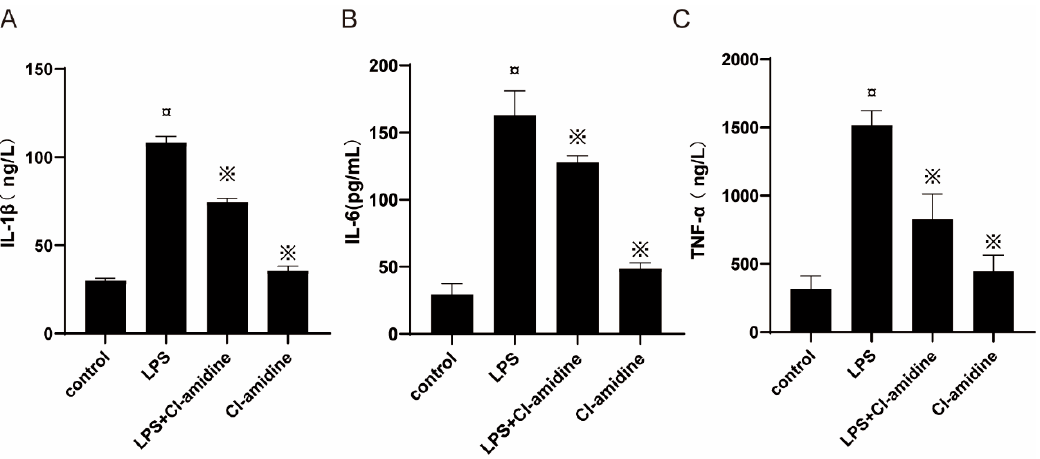
Figure 2. Effects of Cl-amidine on the mRNA levels of pro-inflammatory cytokines in the LPS-induced rat endometritis. Endometritis induced by infusion of LPS (1 mg/kg body weight) into the uterine cavity, later treated with Cl-amidine or vehicle (saline) as required. Samples were collected 24 h after induction of endometritis and Cl-amidine treatment. The mRNA levels of ( A ) IL-1 β , ( B ) IL-6, and ( C ) TNF- α were measured by RT-PCR. Data were represented by mean ± SD ( n = 5 animals per group). ¤ p < 0.05 vs. control rats and ※ p < 0.05 vs. LPS without Cl-amidine.